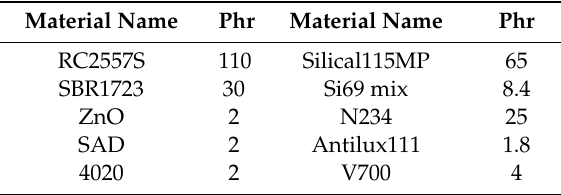
Table 5. Raw materials and dosage for experimental